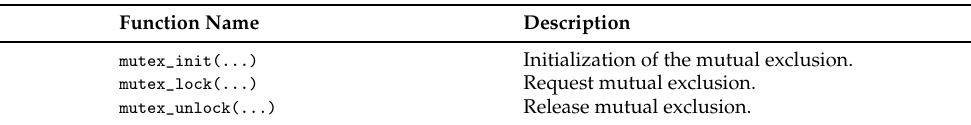
Table 4. Synchronization functions, which are mainly used to read/write on the same FIFO in a mutually exclusive way.